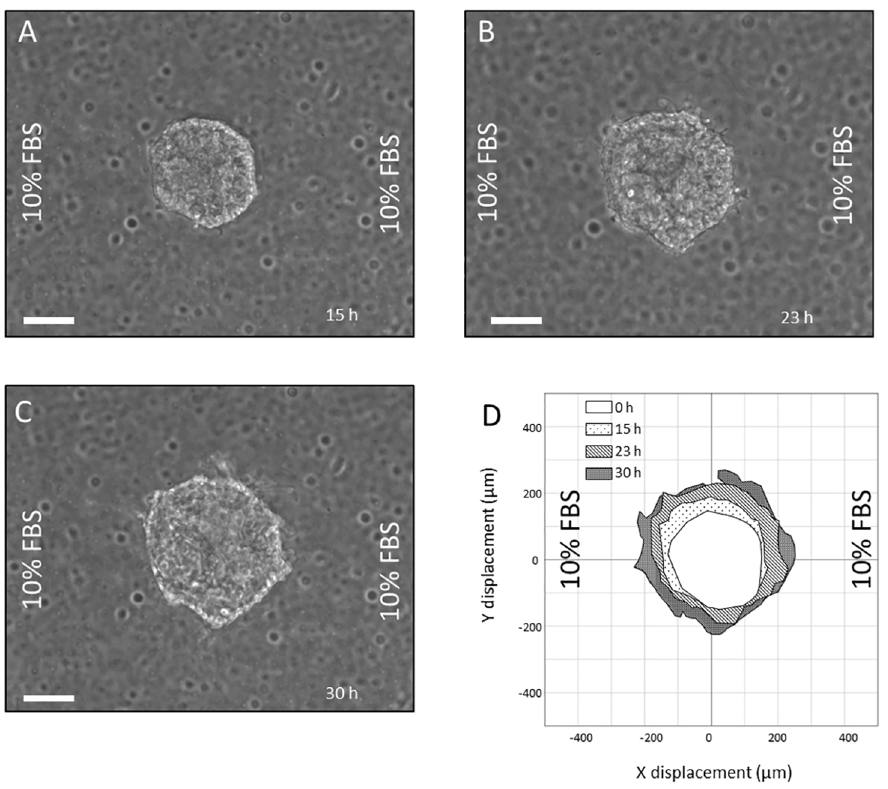
perfused through both lateral microchannels. Spheroid invasion is shown after (A) 15 hours, (B) 23 hours, (C) and 30 hours. (D) Area occupied by the spheroid at different times is represented in the graph. Scale bar is 100 μ